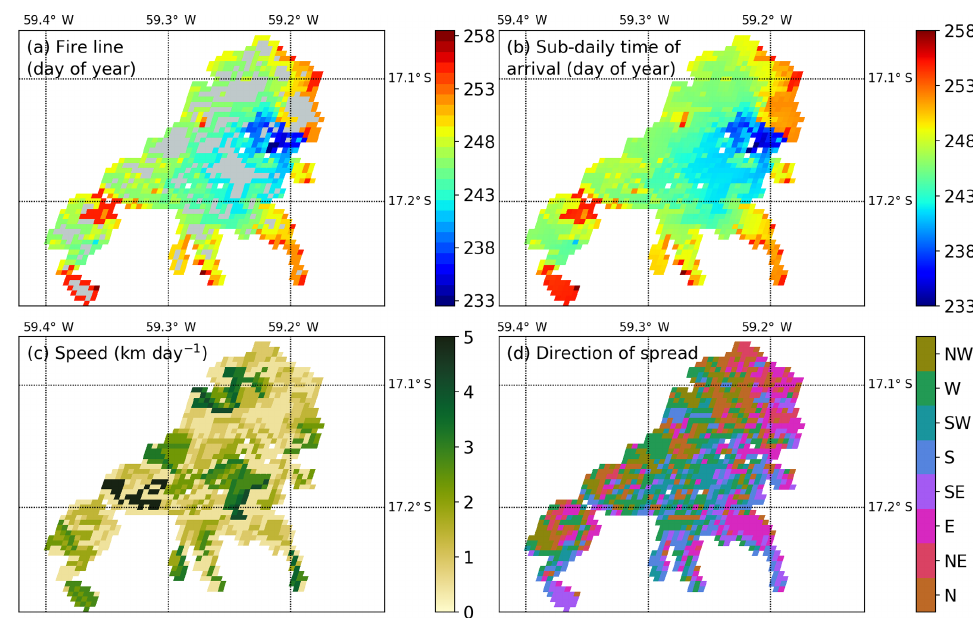
Figure 3. Sub-daily estimates of fire progression can be used to estimate spatiotemporal variation in fire speed and direction of spread. (a) Daily progression of the fire line, (b) interpolated estimates of sub-daily time of arrival, (c) fire speed (kmd − 1 ) and (d) direction of spread. The light gray areas in (a) are burned areas between fire lines and correspond to areas of relatively high fire speed. White areas were not